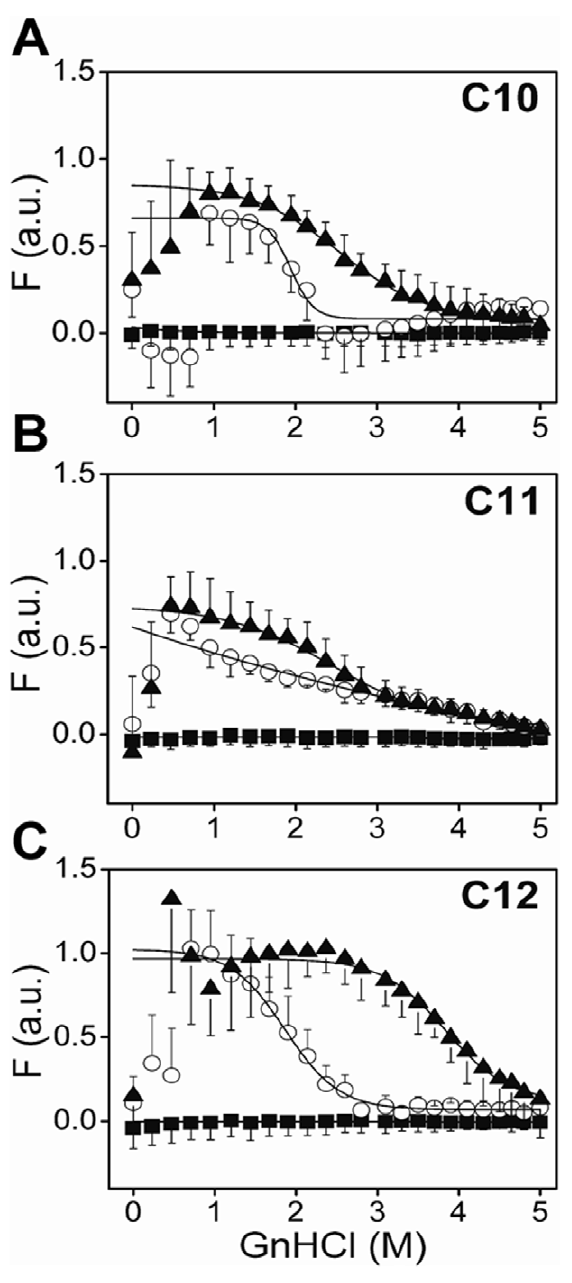
Figure 7. Thermodynamic stabilities of the oligomers deter- mined by GnHCl denaturation experiments. A b 42 (25 m M) was incubated alone ( & ) or with NEFAs C10 (A), C11 (B) and C12 (C)under similar conditions as those represented in Figure 2, at concentrations near ( # ) and above ( m ) the CMCs of the fatty acids. The samples after 48 h incubations were subjected to denaturation by the addition of 6M stock of GnHCl solution. The reactions were monitored by tyrosine intrinsic fluorescence. Three scans were averaged and the areas under the peaks normalized and plotted against GnHCl concentrations. The data was fit using Boltzmann’s sigmoidal fit (Eq 2) by Origin 7.0.